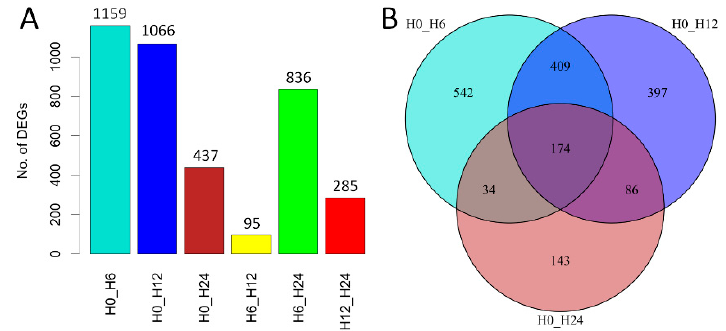
Figure 2. Transcriptome profiling of Spirodela polyrhiza responding to salt treatment. ( A ) Number of di ff erentially expressed (DE) genes identified by pairwise comparison; ( B ) Venn diagrams of DE genes identified between 0 h and 6, 12, and 24 h, respectively. H0, H6, H12, and H24 represent the samples collected from 0, 6, 12, and 24 h after salt treatment, respectively.